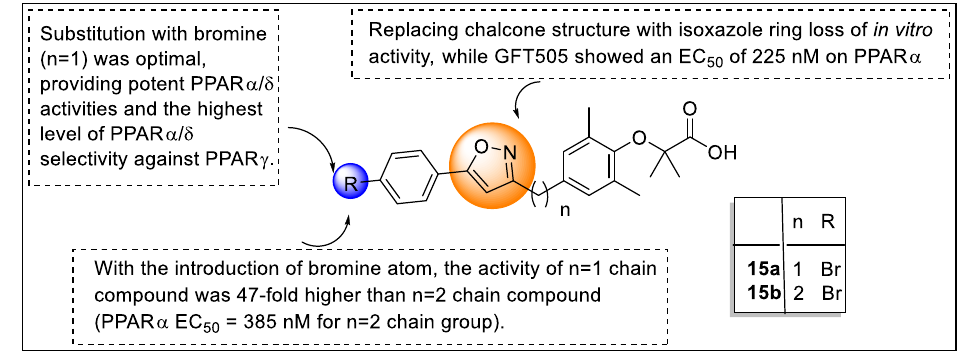
Figure 19. Structural activity relationship of oxazole hybrids ( 15 ) as potent PPAR ligands.